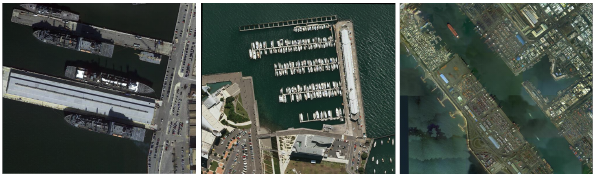
Figure 11. Some samples from DOTA-Ship